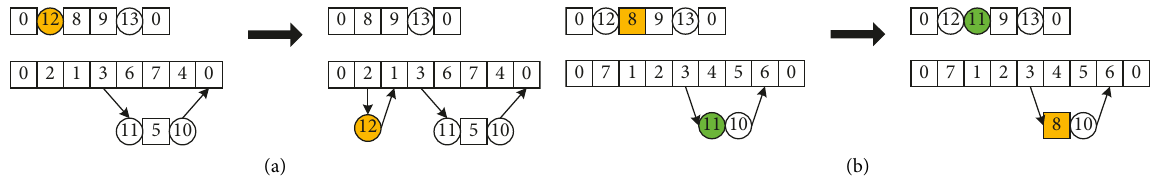
Figure 8: Examples of the interchange operators for one subtour and one UV route.